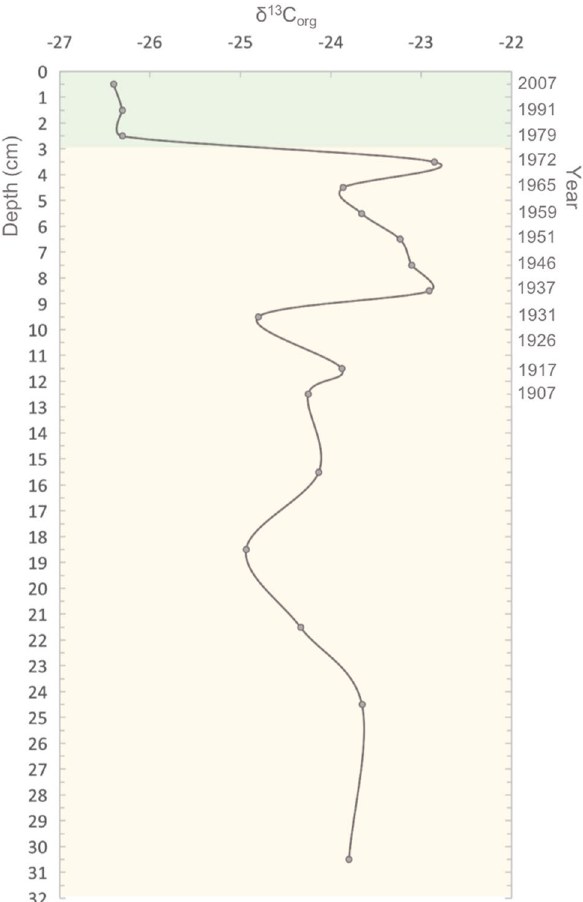
Figure 5. Changes in δ 13 C org along sediment depth (left axis) and time (right axis) in the core BS2A1 . Green color indicates the period after the building of the bridge in